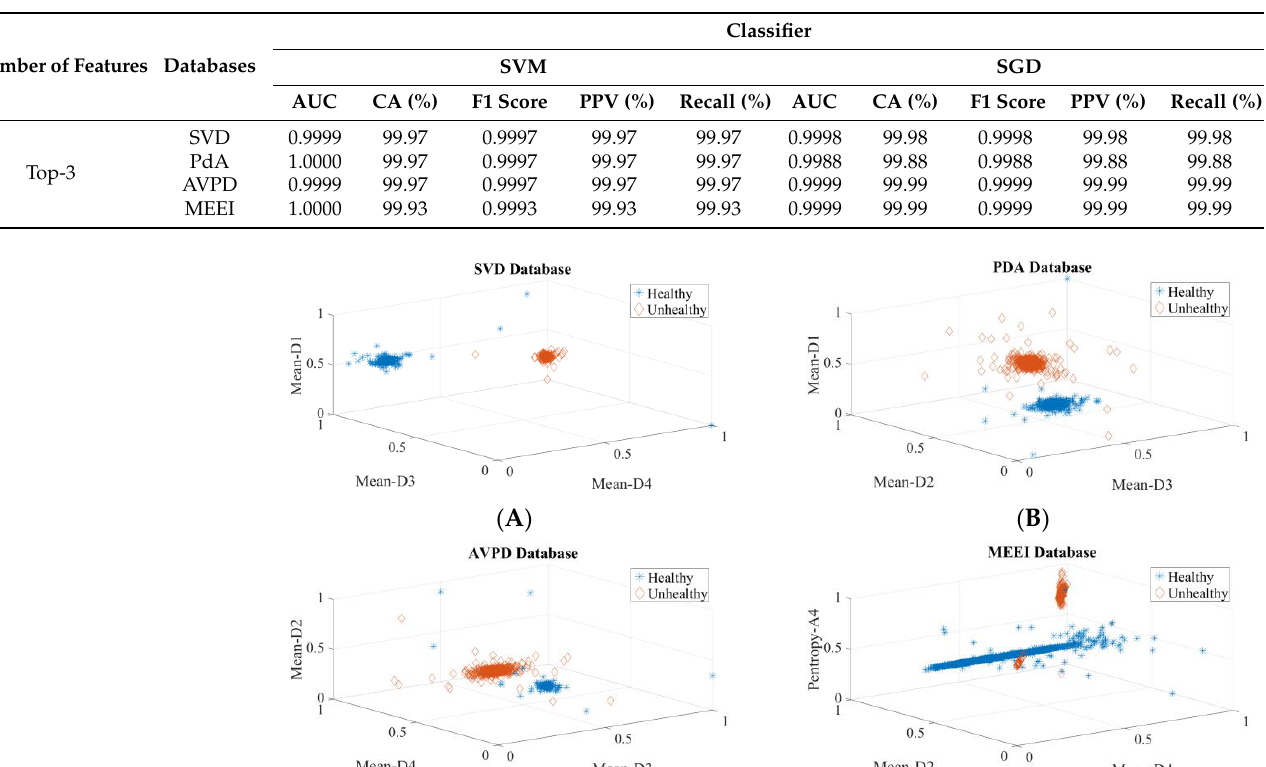
Table 5. Performance indicators for SVM and SGD classifiers for multiclass.